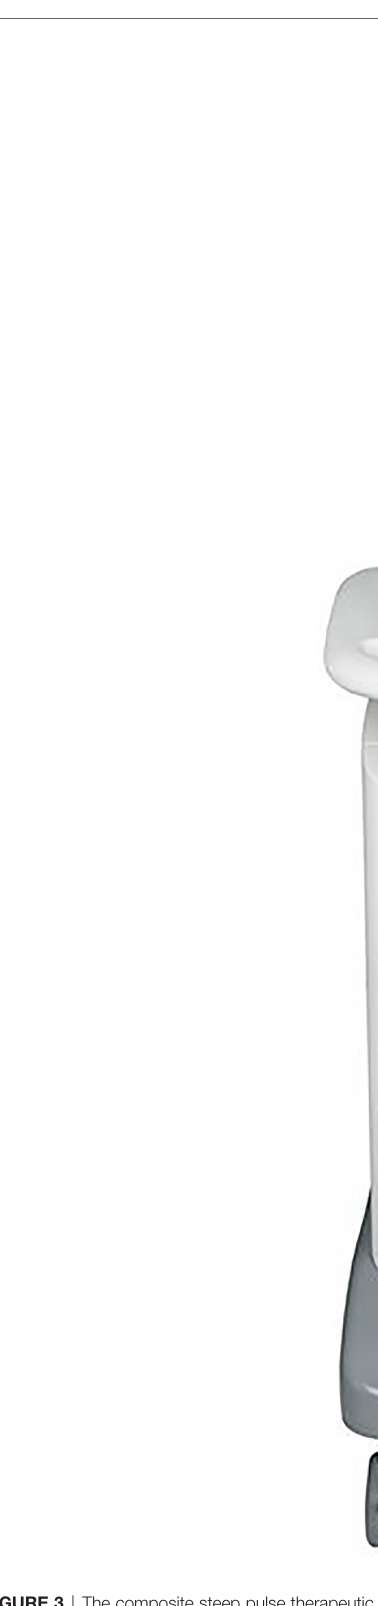
FIGURE 3 | The composite steep pulse therapeutic apparatus (REMEDINE, Shanghai,